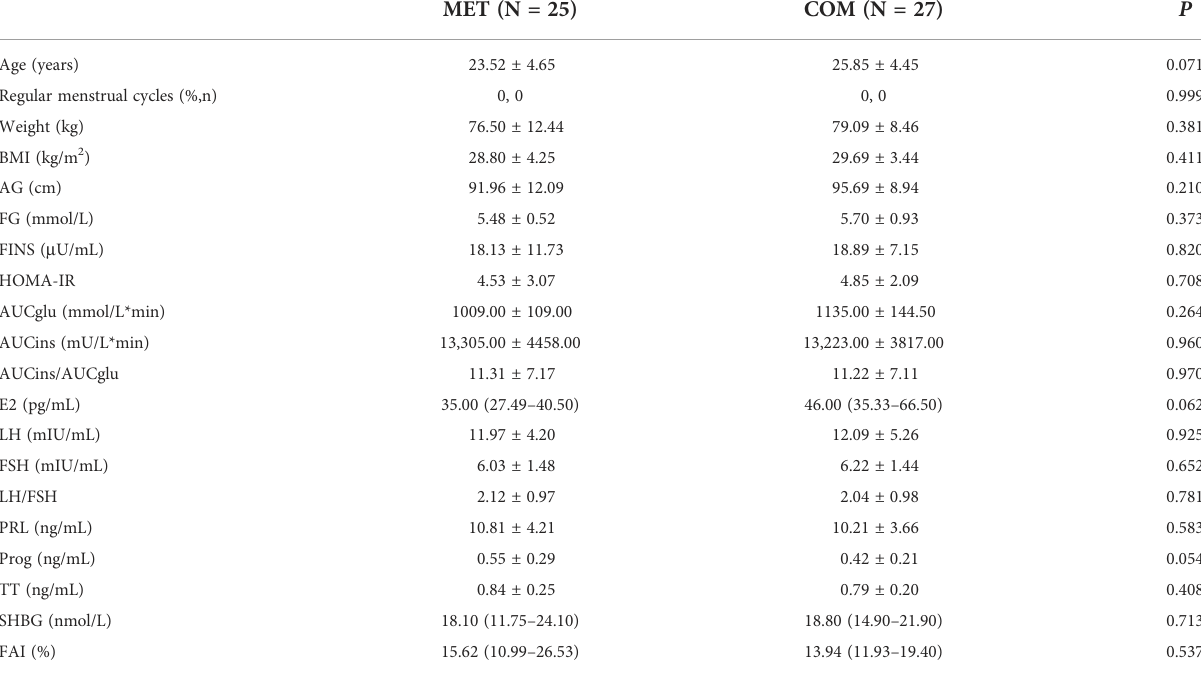
BMI, body massindex; AG, abdominal girth; FG,fasting glucose; FINS, fasting insulin; HOMA-IR, homeostasis model assessment-insulin resistance; AUCglu, area underthe curve (AUC) for glucose; AUCins, AUC for insulin; E2, estradiol; LH, luteinizing hormone; FSH, follicle-stimulating hormone; PRL, prolactin; Prog, progesterone; TT, total testosterone; SHBG, sex hormone-binding globulin; FAI, free androgen index. Results are expressed as mean ± SD or median (25 th – 75 th